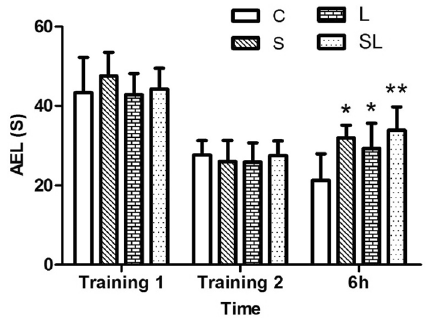
Figure 1. The AELs of the rats during the MWM test. The data are presented as the means ± SDs. * p < 0.05 and ** p < 0.01. compared to the C group. “C” stands for the control group, “S” stands for the 2.856 GHz microwave exposure group, “L” stands for the 1.5 GHz microwave exposure group, and “SL” stands for the 2.856 and 1.5 GHz cumulative exposure group.